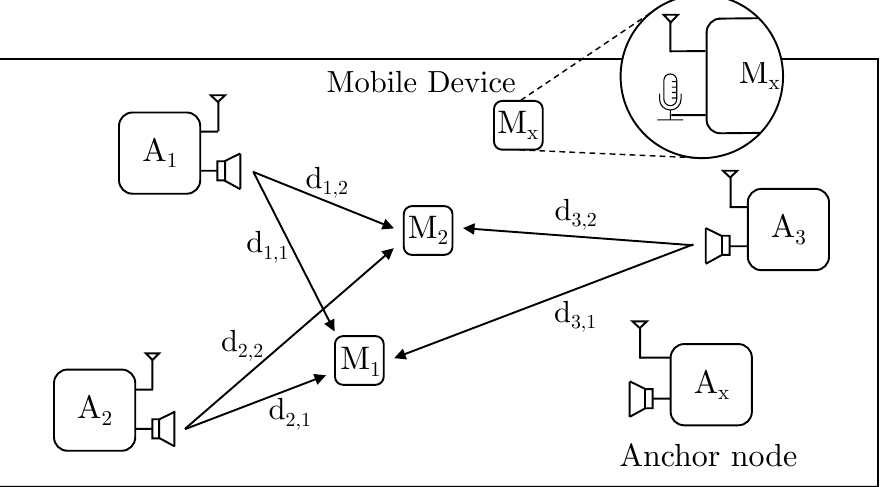
Figure 2. Overview of a hybrid RF-acoustic indoor positioning